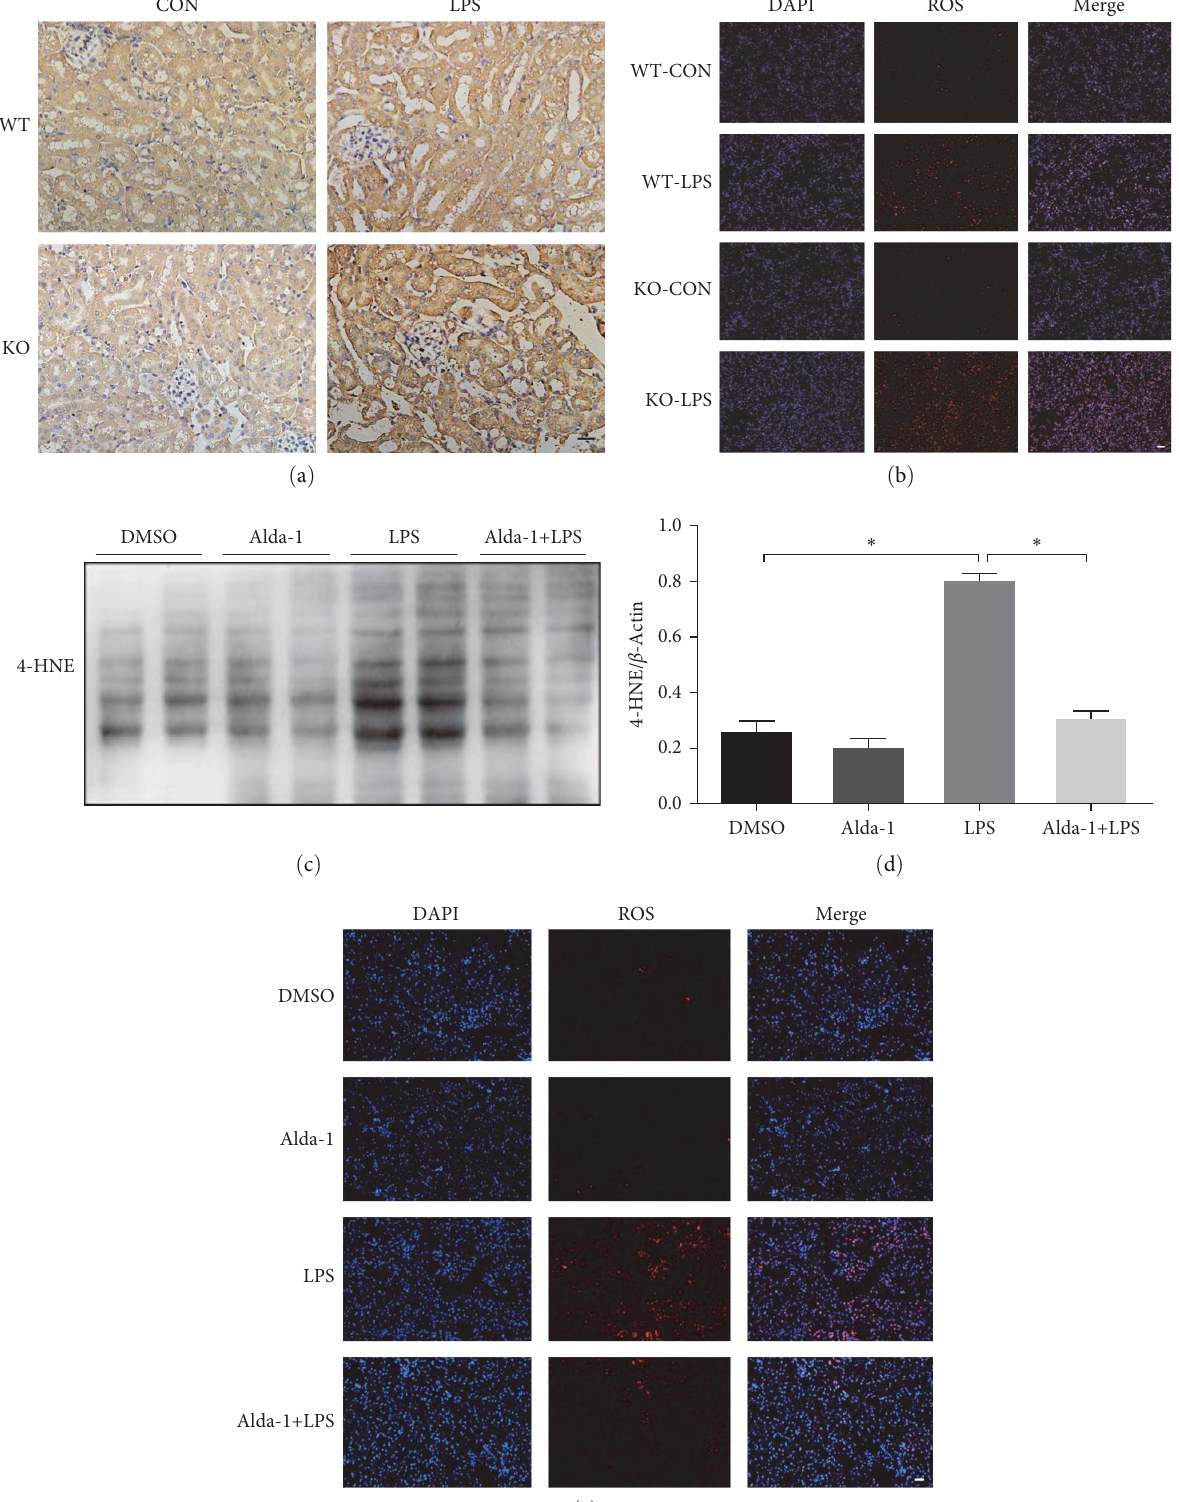
F IGURE 4: Role of ALDH2 on the LPS-induced 4-HNE accumulation and ROS generation: (a) immunohistochemical staining for 4-HNE expression in kidneys in WT and KO mice after LPS administration; (b) ROS expression in kidneys in WT and KO mice after LPS administration; (c, d) representative western blots and quanti fi cation analysis of 4-HNE and β -actin (loading control) with or without Alda-1 pretreatment in WT mice; (e) ROS expression in kidneys with or without Alda-1 pretreatment in WT mice. Scale bars: 50 μ m. All data are expressed as mean Æ SEM ( n = 6). ∗ P < 0 :